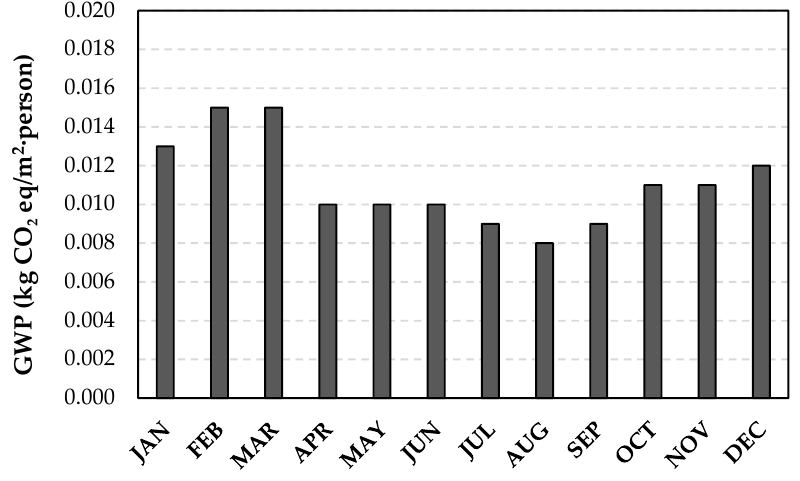
Figure 6. Breakdown of the total global warming potential (GWP) throughout the year.